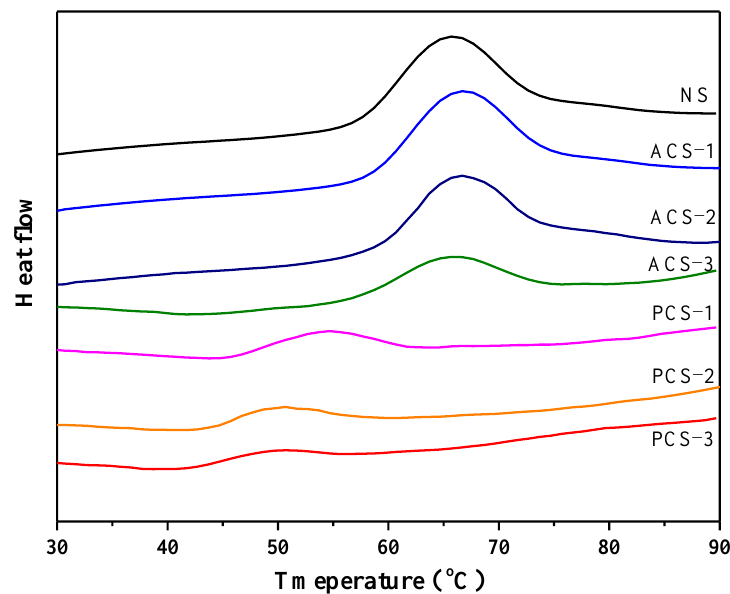
Figure 5. DSC thermograms of native, phosphorylated and acetylated chestnut starch. Table 3. Thermal properties of native, phosphorylated and acetylated chestnut starch.